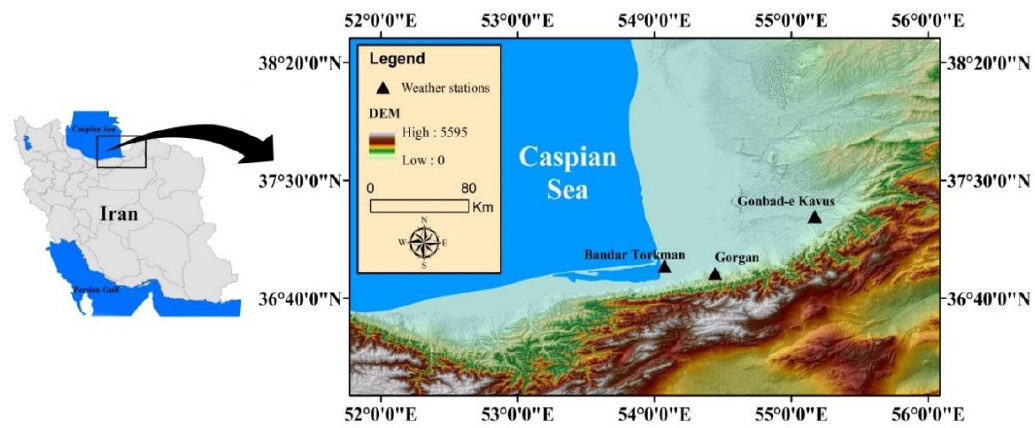
Figure 1. The geographical location of the study area. Table 1. Statistical characteristics of the utilized data in three studied stations.